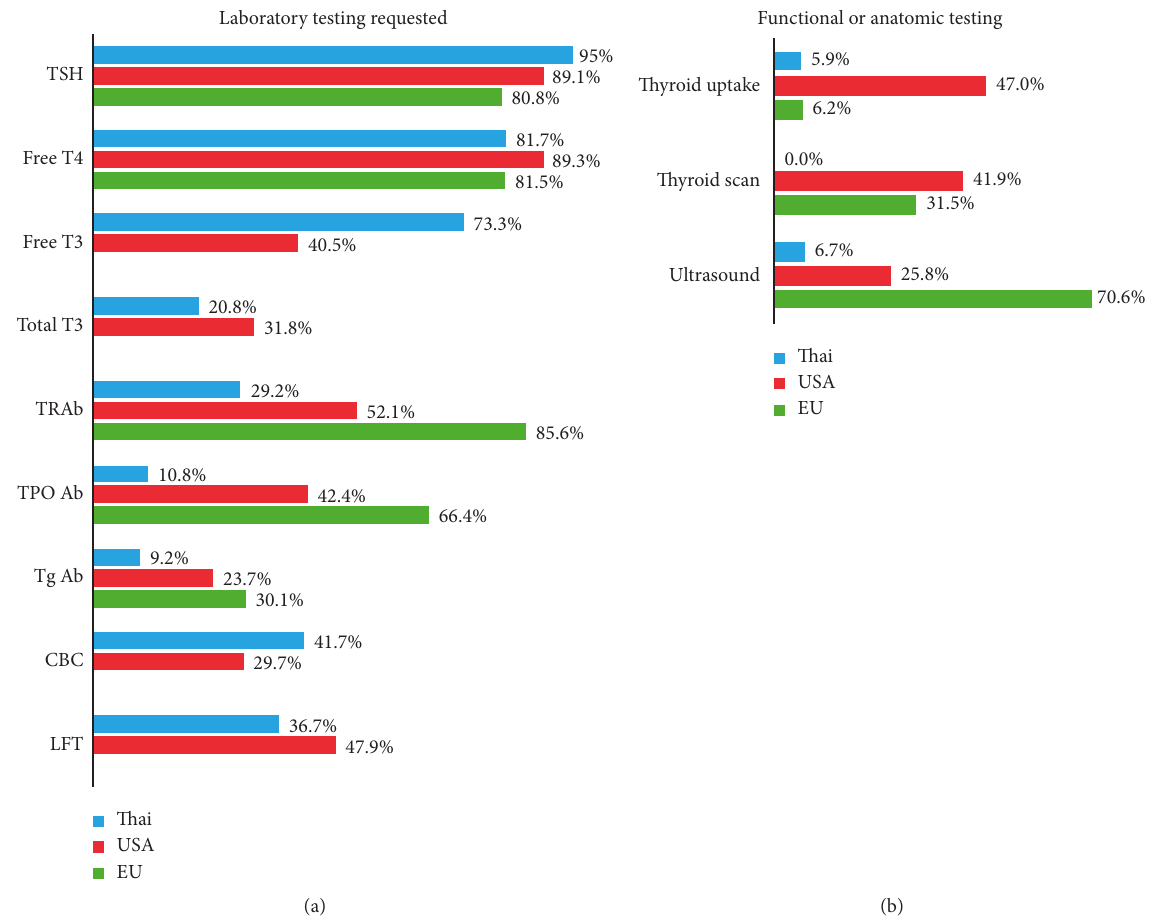
Figure 1: Percentage of participants who would obtain the listed laboratory test (a) or functional and anatomic study (b) in a patient with uncomplicated Graves’ disease. International differences in the selection of laboratory tests or imaging studies are also shown. USA and EU data are from references 5 and 6, respectively. CBC, complete blood count; EU, Europe; LFT, liver function test; T3, triiodothyronine; T4, thyroxine; Tg Ab, thyroglobulin antibody; TPO Ab, thyroperoxidase antibody; TRAb, TSH receptor antibody; USA, United States of America.